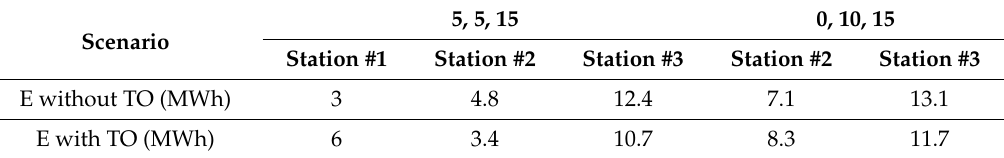
Table 7. Weekly energy demand for the stations in di ff erent scenarios.